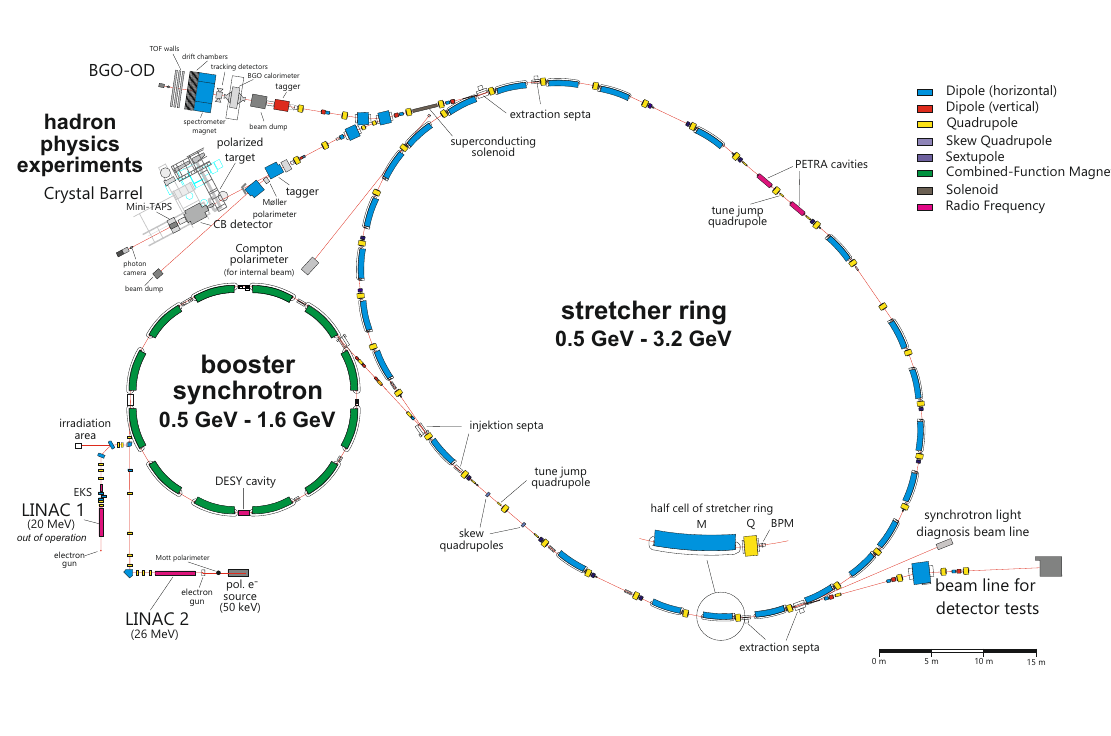
Figure 2. Overview of the ELSA accelerator facility. Figure adapted from Ref. [24].